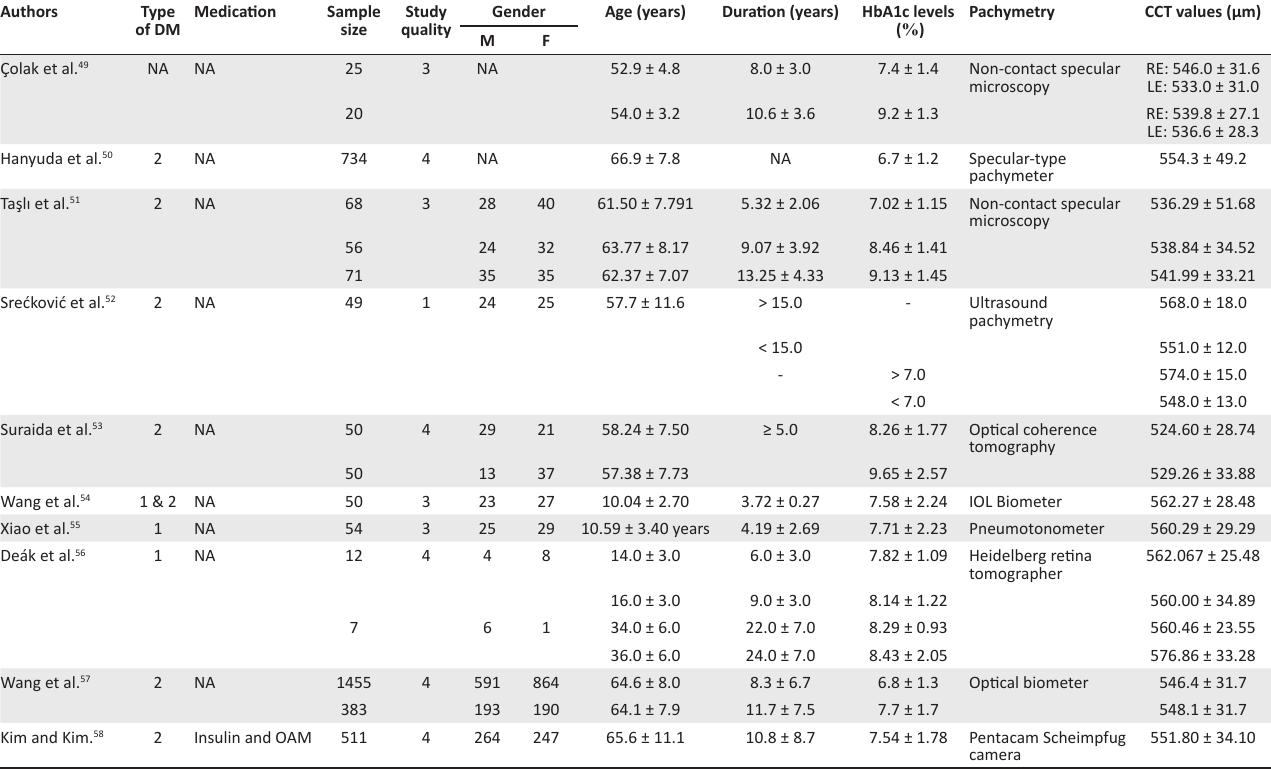
TABLE 1 (continues ...): Studies included in this systematic review.